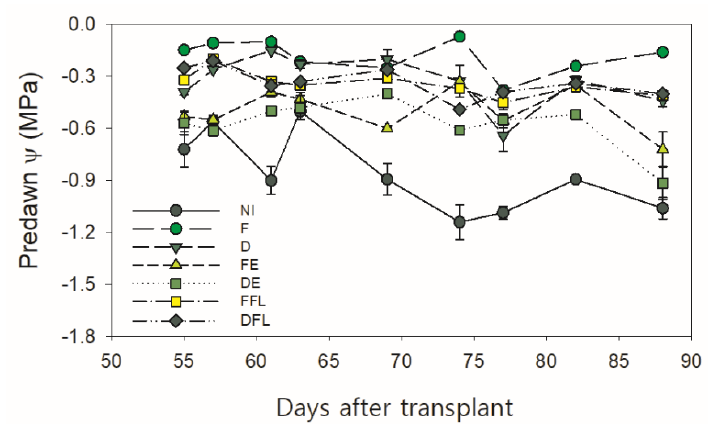
Figure 5. Course of “predawn” water potential (ψ, MPa) during the growth period in processing tomatoes cv. Hypeel F1 under different irrigation treatments.